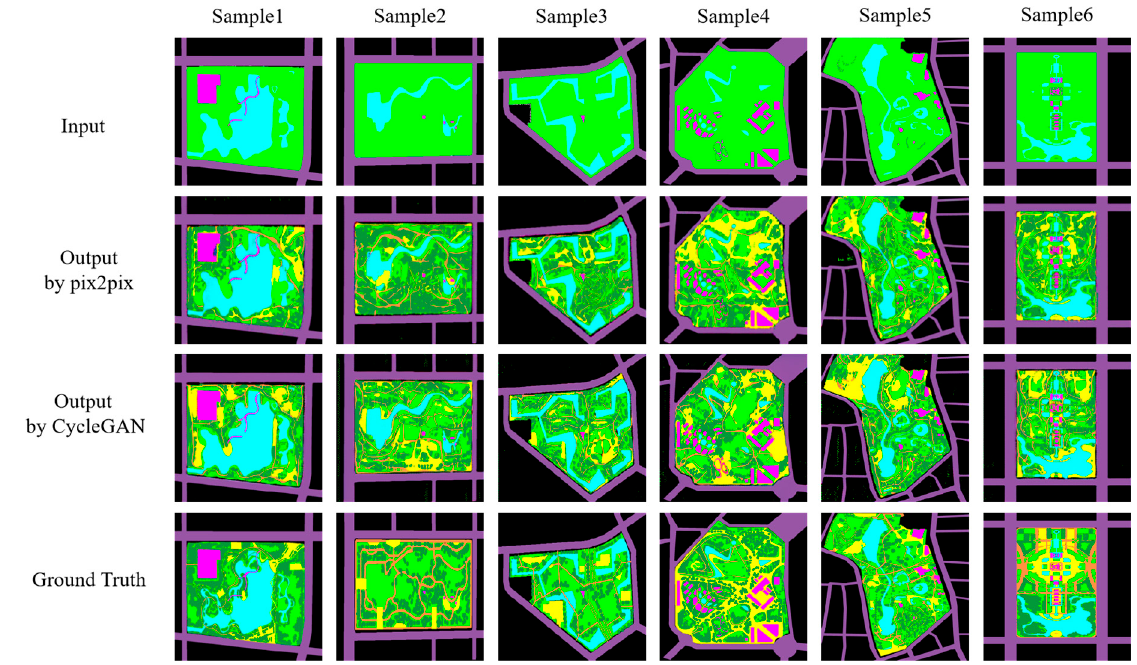
Figure 13. Layout generation experiment results.